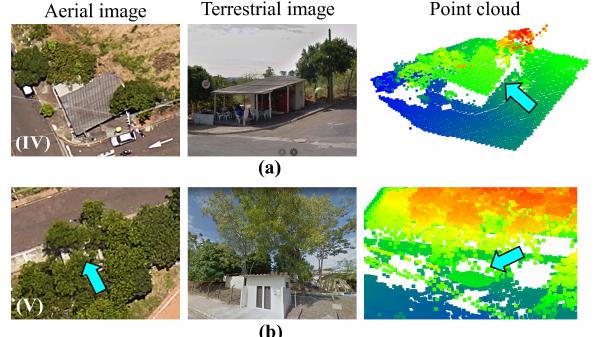
Figure 8. Buildings partially occluded by tall trees. The cyan arrows indicate the interest buildings.